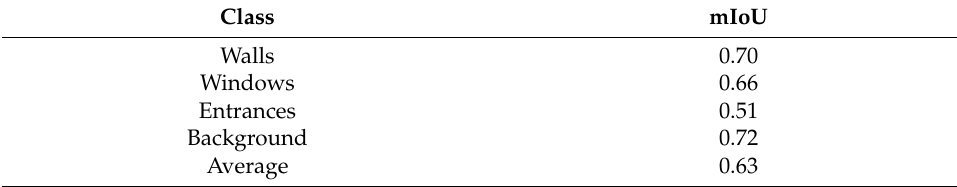
Table 8. mIoU of CMP test data.